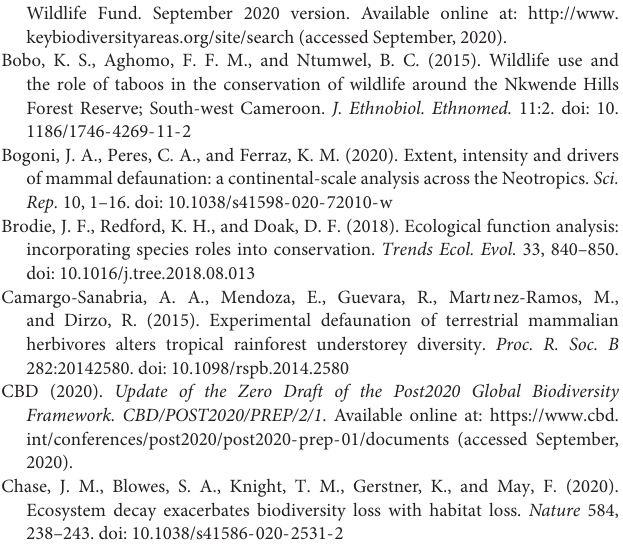
Supplementary Figure 1 | Plot of number of species extirpated against human footprint score for 3,474 randomly assigned points across the land surface of the planet. While a positive linear correlation exists R 2 is only 0.21. Supplementary Figure 2 | Location of land with (A) HF ≤ 4 and (B) faunal intactness. Colors represent different ecoregions, gray is land that does not meet the criteria. Supplementary Table 1 | The species name, threshold density and source of data for rangewide species distribution maps for the species that were used to assess impacts on functional